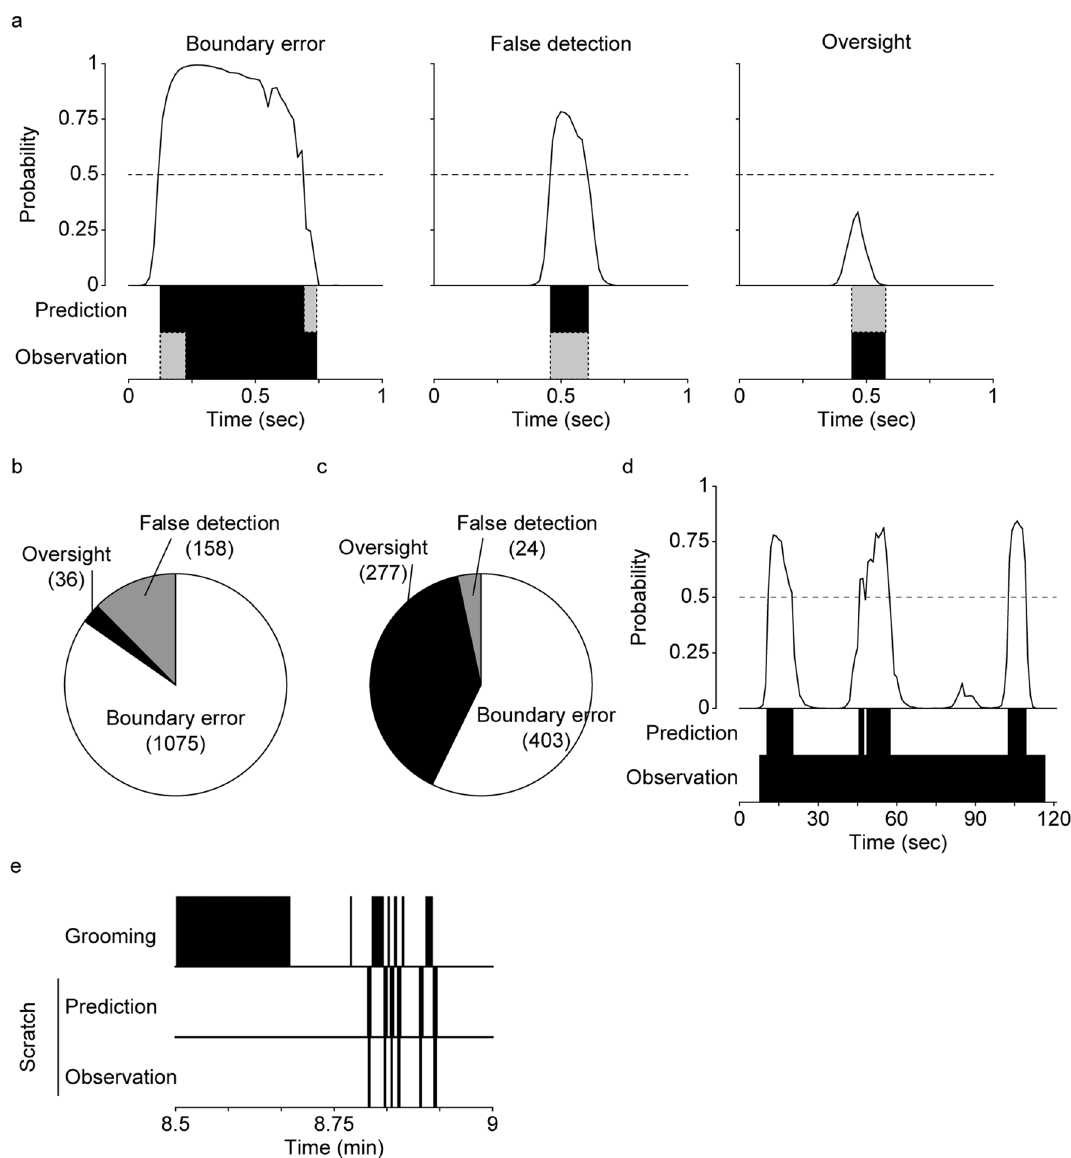
Figure 4. The detailed investigation of error segments. ( a ) Three error types. Black boxes indicate scratching segment in prediction or observation. Grey boxes indicate error segment. ( b ) The number of three errors in the training dataset. ( c ) The number of three errors in the test dataset. ( d ) Detailed investigation of the significantly deviated scratching event (indicated by arrow in Fig. 3g). ( e ) The representative data of grooming and scratching. Black boxes indicate grooming or scratching